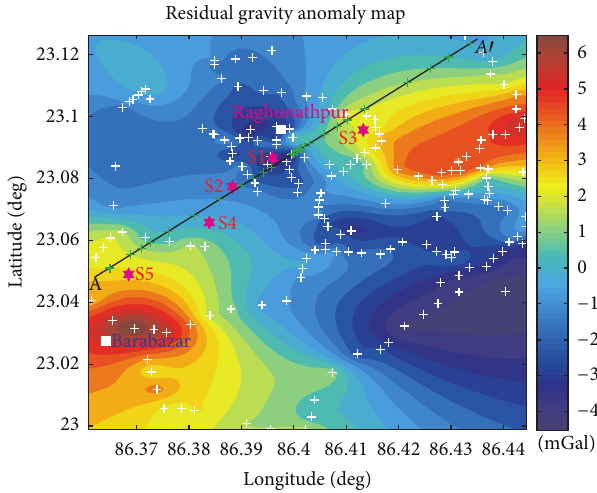
Figure 4: Residual gravity anomaly map of the study area after separation of 3rd degree trend surface polynomial from Bouguer anomaly. Plus (+) symbols are the gravity survey locations.